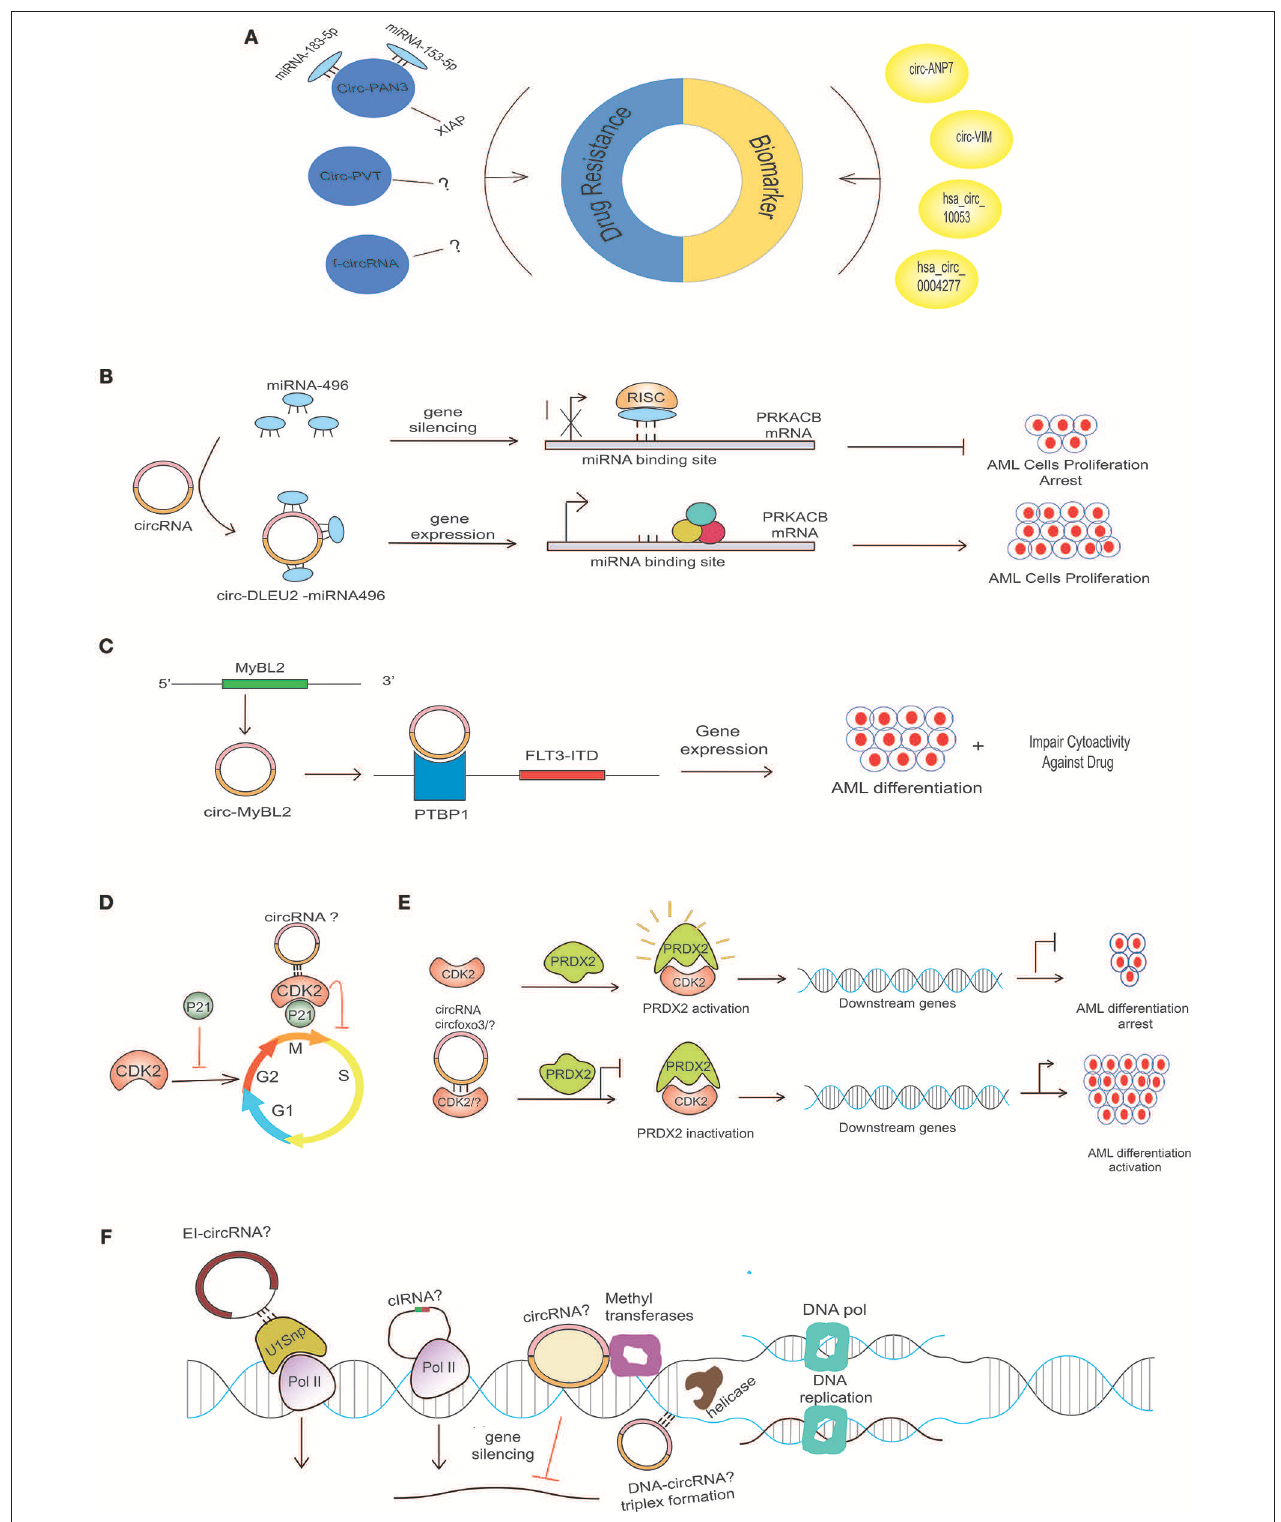
FIGURE 2 | Possible mechanism of circRNA in AML pathogenesis. (A) Aberrant expression of various circRNAs detected in BM samples of AML patients can be implicated in the diagnosis and prognosis of AML. circRNAs use different mechanisms to contribute to drug resistance in AML. CircPAN3 binds with two different